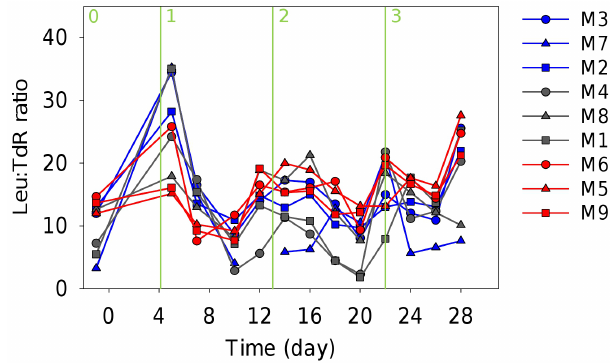
Fig. 5. Temporal variation of Leu:TdR ratio. For colour and symbol coding, see Fig.